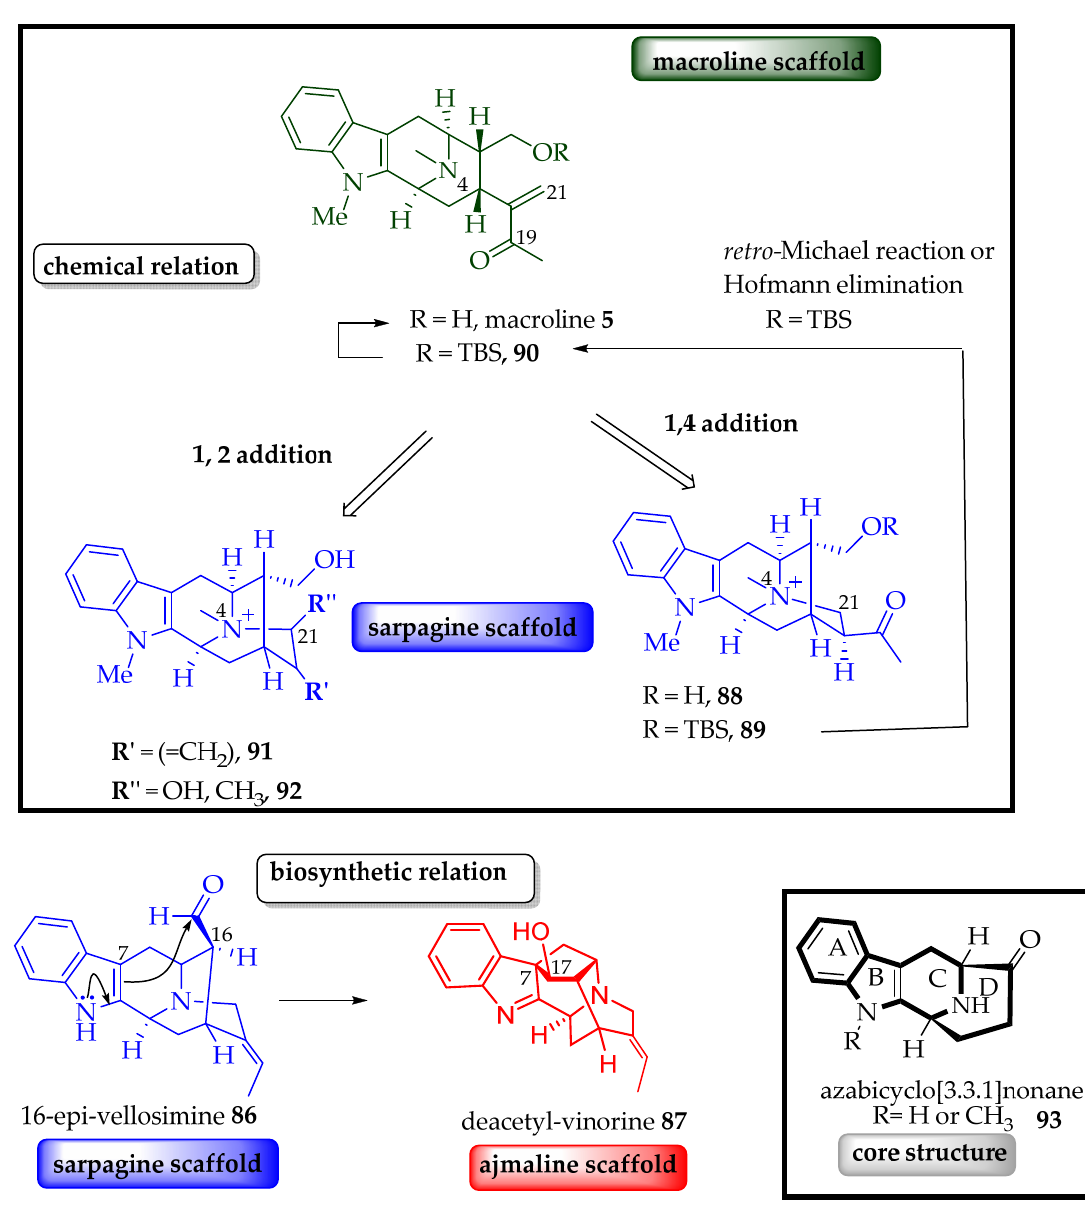
Figure 7. Abbreviated chemical and biosynthetic relations among the sarpagine/macroline/ajmaline family of alkaloids.